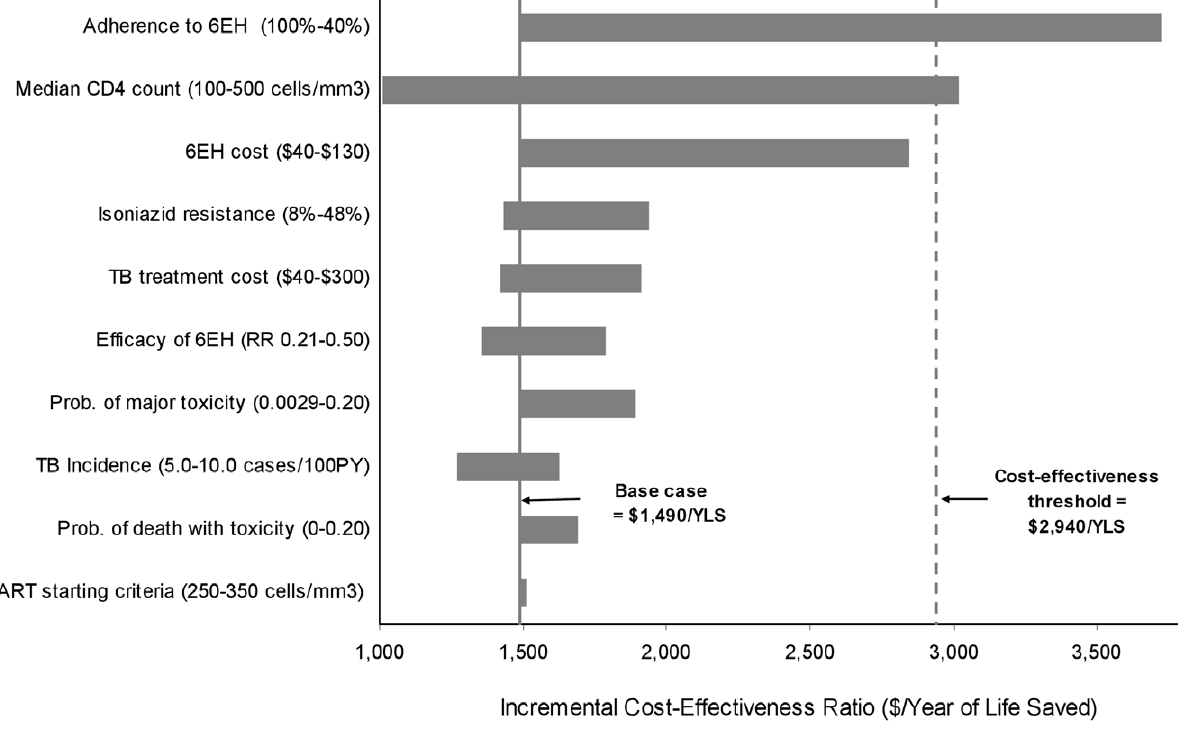
Figure 1. Tornado diagram of one-way sensitivity analyses comparing the 6EH regimen to no IPT . Selected model parameters are listed on the vertical axis, with the range examined in sensitivity analyses listed in parentheses. The length of the horizontal bar demonstrates the impact of changes in the parameter values on the incremental cost-effectiveness ratios for the 6EH regimen compared to no IPT. The solid vertical line indicates the incremental cost-effectiveness ratio estimate ( $ 1,490/YLS) of the base case, and the dashed vertical line indicates the suggested cost-effectiveness threshold ratio of $ 2,940/YLS (3x GDP India). Values in white in the center of the bars indicate the threshold value of each parameter at which the cost-effectiveness ratio for 6 months of IPT compared to no IPT is equal to $ 2,940/YLS. For example, Adherence to the 6EH regimen was varied from 40%–100%. The incremental cost-effectiveness ratio of 6EH compared to no IPT was less than or equal to $ 2,940/YLS (i.e. cost-effective by international standards) when percent cohort completion was as low as 55%. 6EH : Six-month regimen of isoniazid plus ethambutol, IPT :